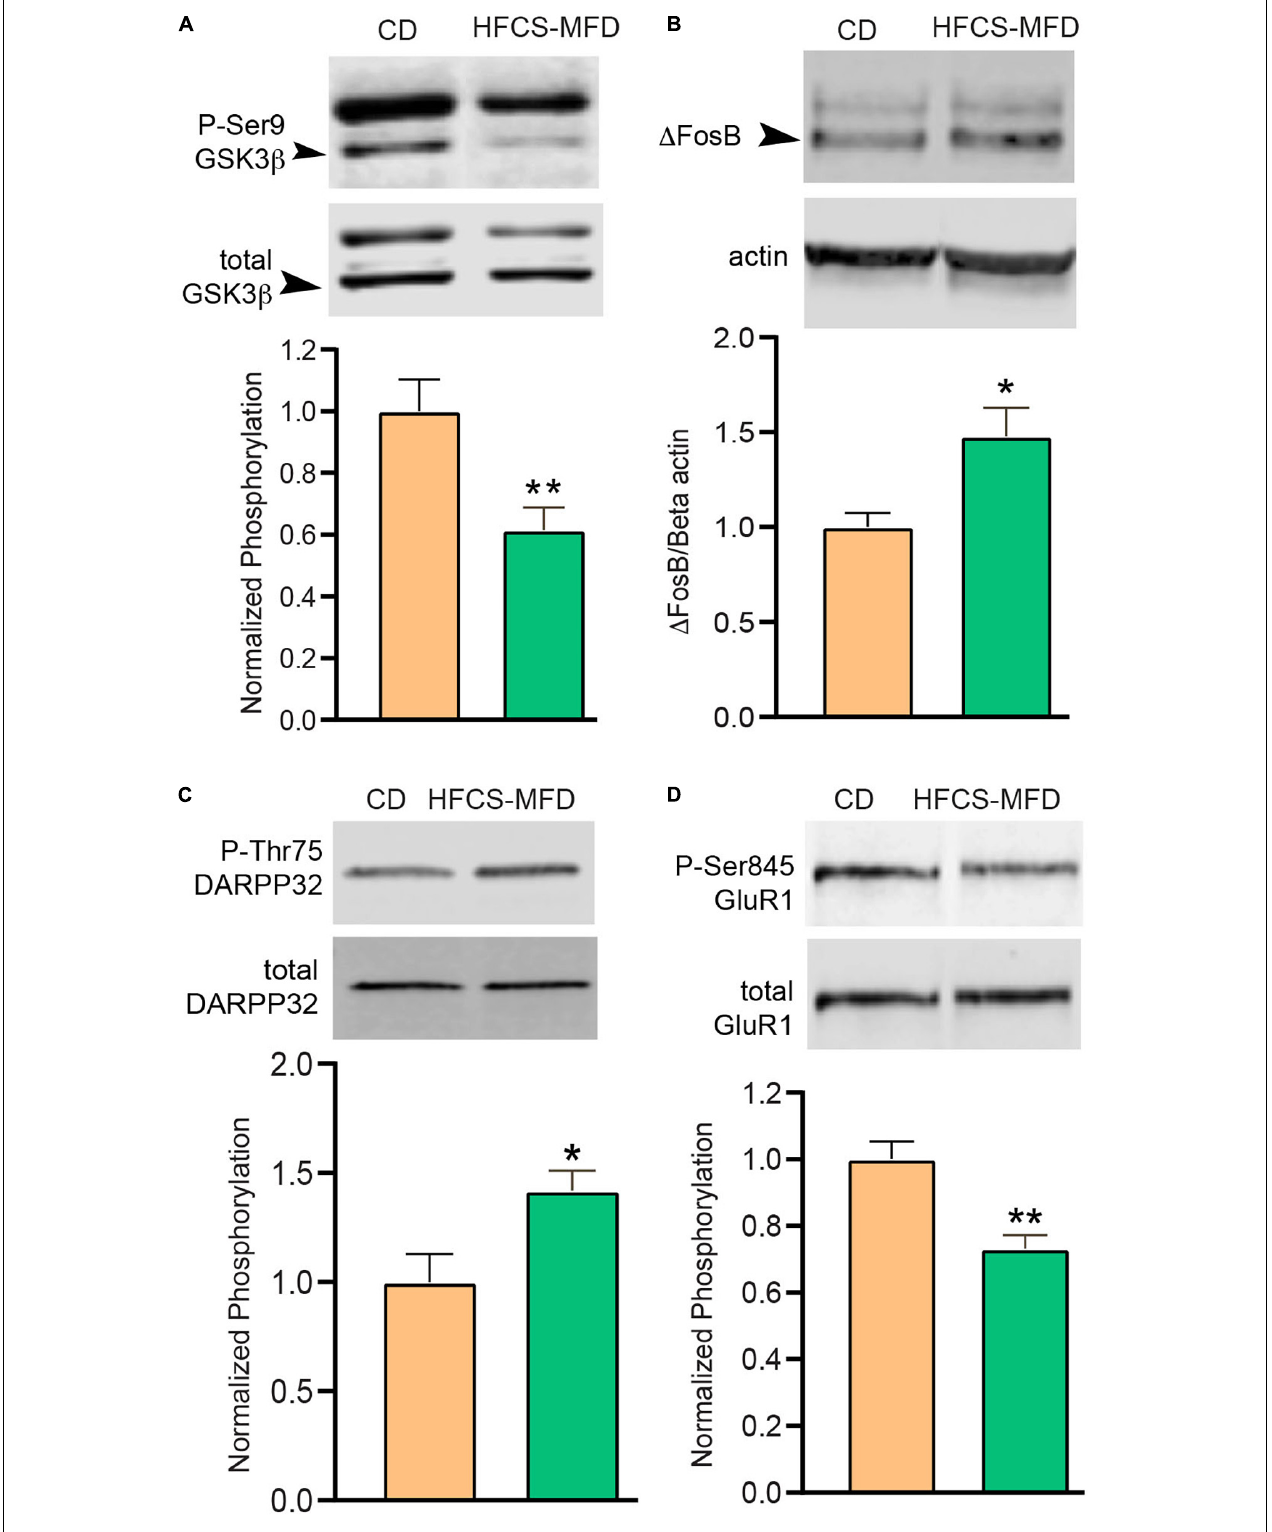
FIGURE 5 | HFCS-MFD alters ventral striatal neuronal signaling. The effects of HFCS-MFD vs CD on (A) phospho-Ser9GSK3 β , (B) (cid:49) FosB, (C) phospho-Thr75 DARPP-32 and (D) phospho-Ser845GluR1 protein levels in ventral striatal lysates of mice following 16 weeks of diet are shown, ( n = 4-6 per group; * p < 0.05, ** p < 0.01 unpaired t-